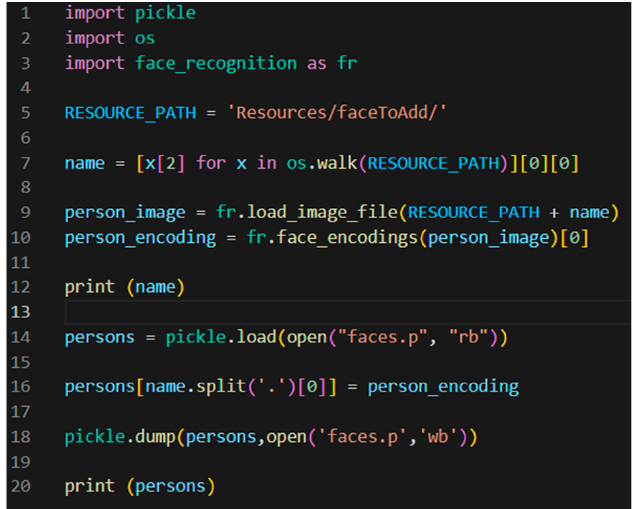
Figure 10. Partial Code of the added face to the database file.